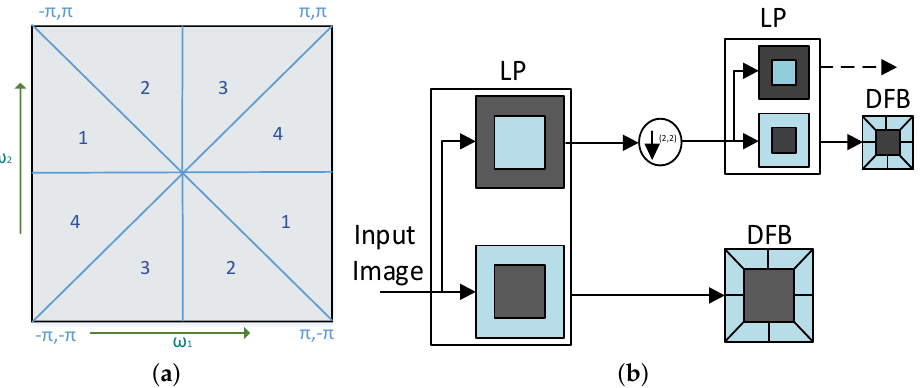
Figure 4. ( a ) Wedge-shaped frequency response for 4-band decomposition and ( b ) Contourlet Transform working